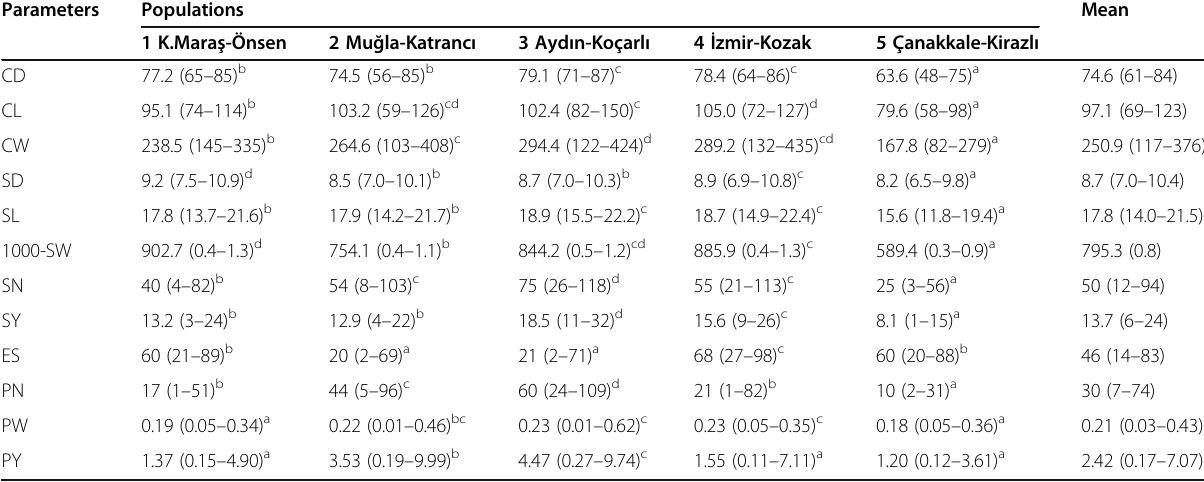
Table 3 Cone and seed morphometric traits of five stone pine ( P . pinea ) populations in Turkey